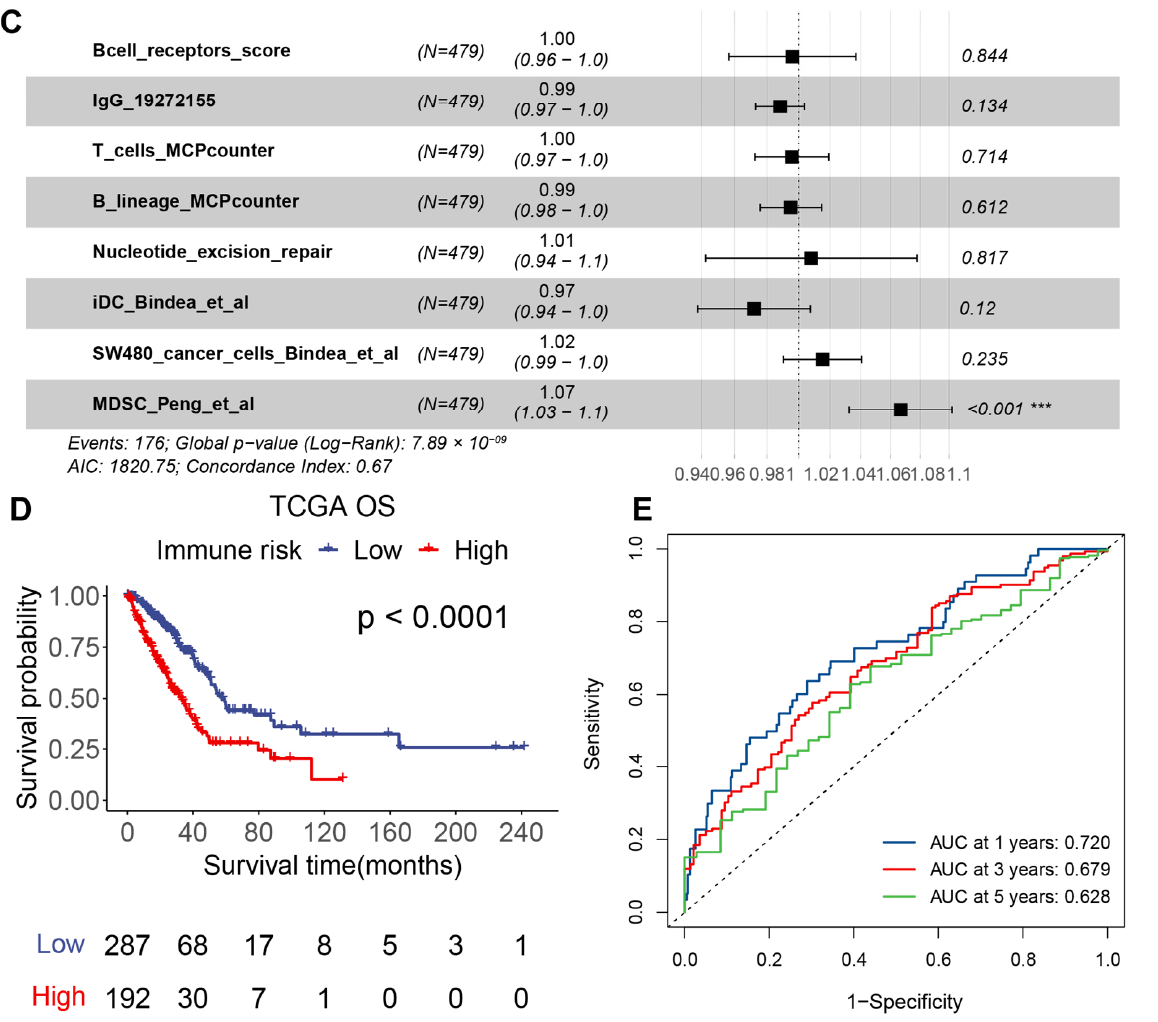
Figure 2. Establishment of TMERSscore. ( A ) LASSO coefficient profiles of the 18 selected TMERSs. ( B ) Adjusting LASSO penalty parameters using 10-fold cross-validation. ( C ) Multivariate Cox re- gression analysis of the eight selected TMERSs for OS. ( D ) Kaplan-Meier survival curve of the TMERSscore in the training cohort. ( E ) ROC curves of TMERSscore predicting OS. *** p <